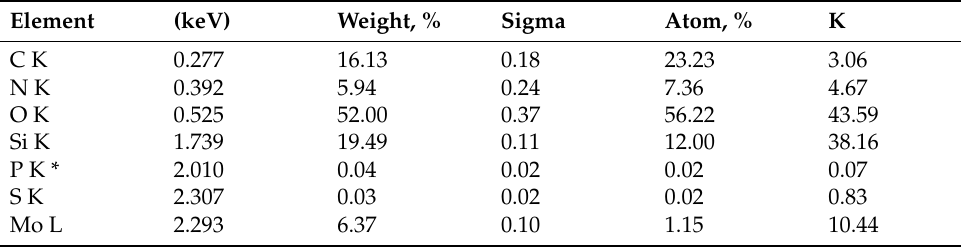
Table 1. Distribution of elements on the PMo1 surface according to EDA data.